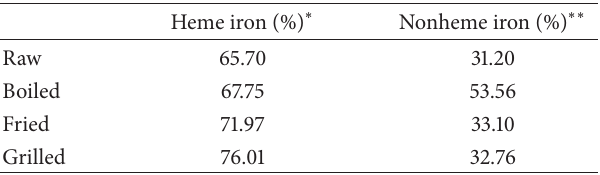
Nonheme iron determined by Ferrozine